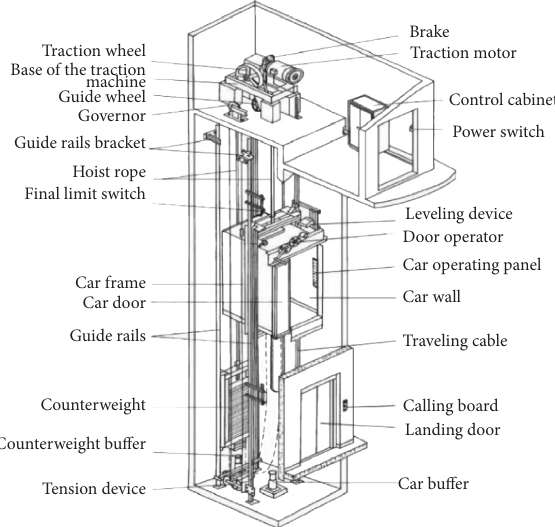
Figure 2: The structure of the